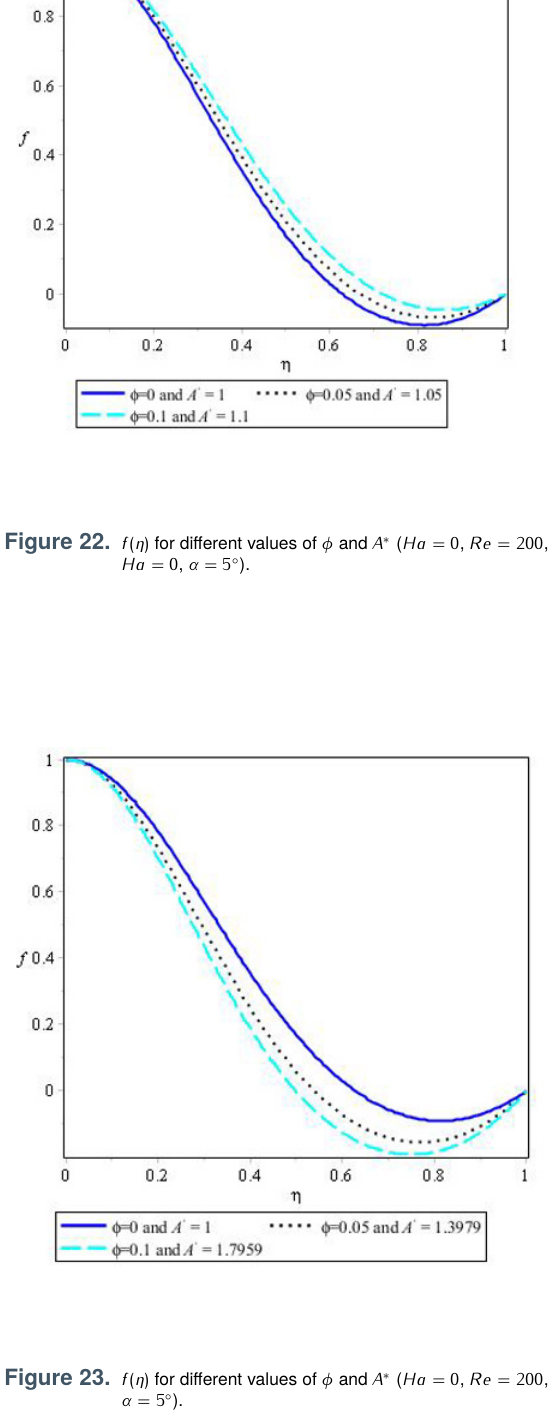
Figure 23. f ( η ) for different values of φ and A ∗ ( Ha = 0 , Re = 200 , α = 5 ◦